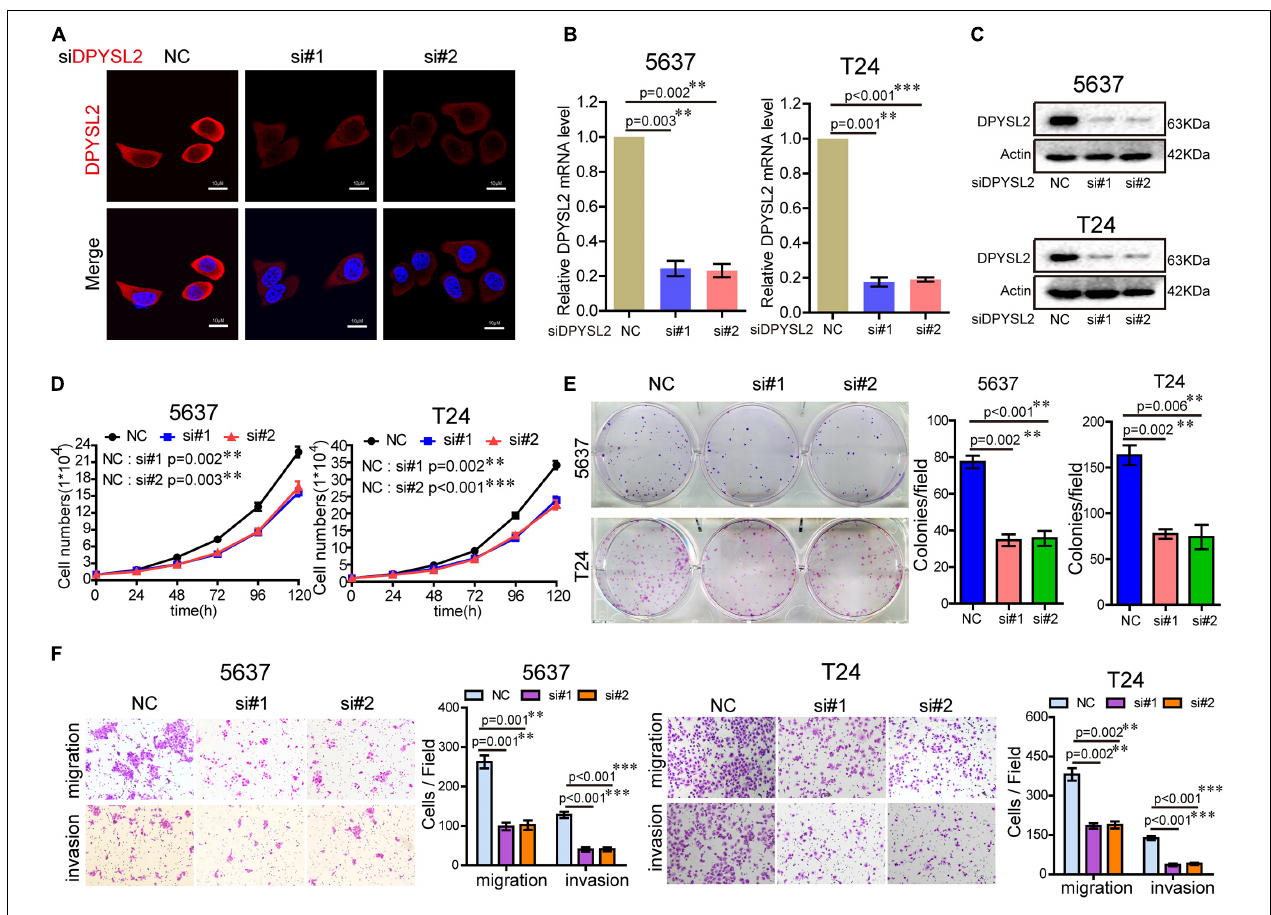
FIGURE 2 | Knockdown of DPYSL2 inhibited cell proliferation, colony formation, migration, and invasion of bladder cancer cells. (A) T24 cells were transfected with small interfering RNA against DPYSL2 (siDPYSL2) or negative control. DPYSL2 was immunostained with an anti-DPYSL2 antibody and detected by immunofluorescence microscopy. Representative images are shown. Magnification 200 × . (B,C) 5637 and T24 cells were transfected with siDPYSL2 or negative control. qRT-PCR and Western blot analysis were performed to measure the mRNA and protein levels of DPYSL2. (D–F) Cell proliferation, colony formation, migration, and invasion assays were conducted. Data are expressed as the mean ± SEM. ** P < 0.01, *** P < 0.001; n = 3. NC, negative control; si, small interfering